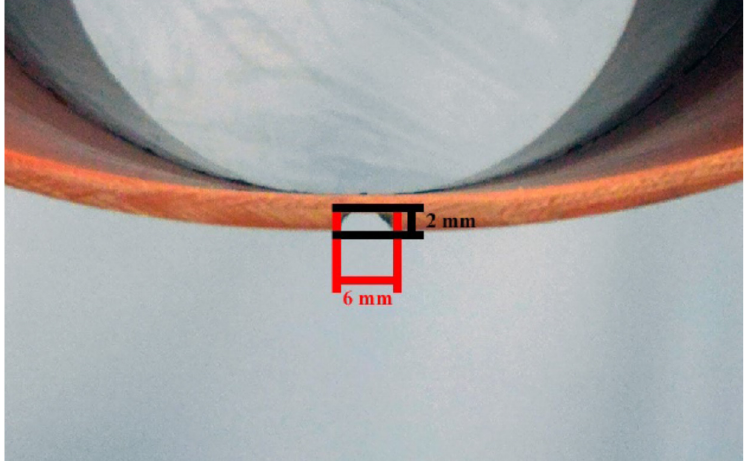
Figure 2. Damage made on the cylindrical specimen at 180° starting from the cylinder attachment point. ment point.